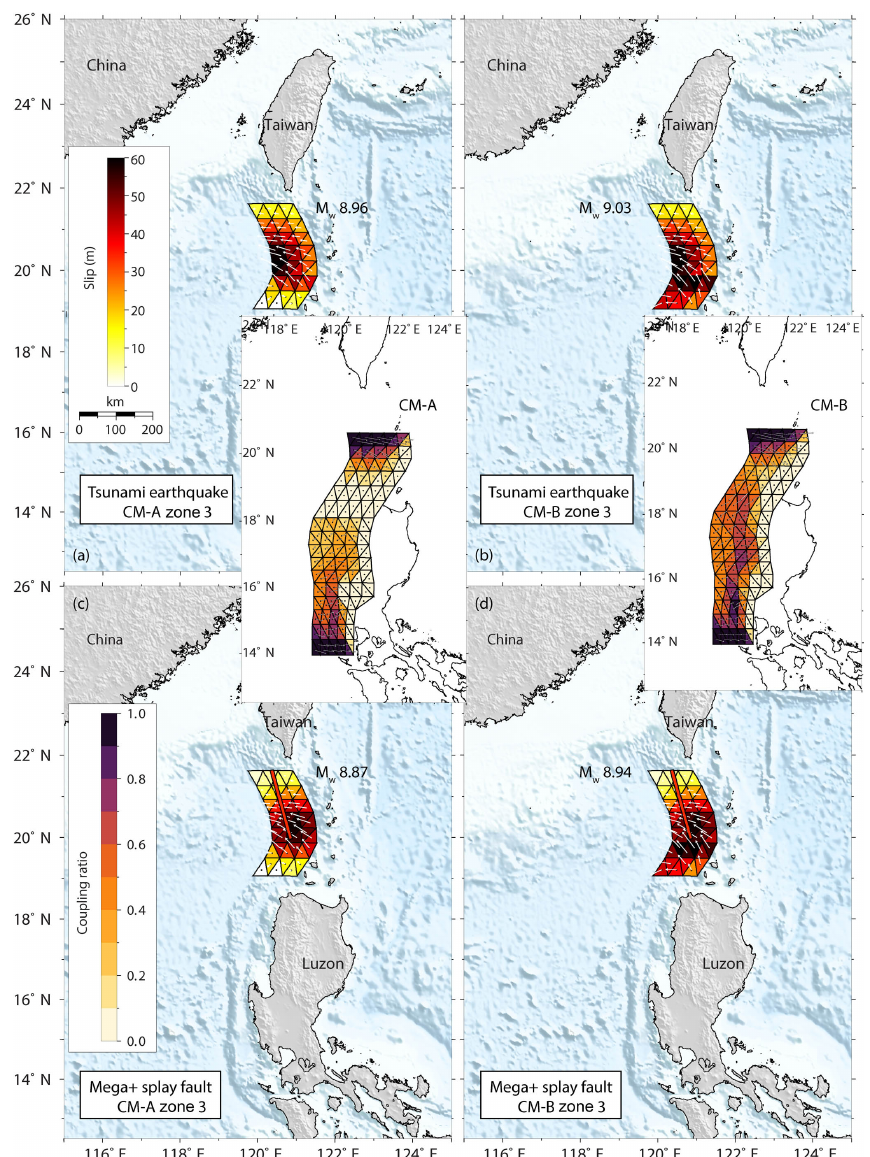
Figure 5. Proposed slip models in zone 3. Panels (a, b) show the shallow rupture type of slip models (e.g., Tohoku-Oki) based on coupling models A and B (Hsu et al., 2016), respectively. Panels (c, d) represent megathrust (Fig. 3c and f) rupture and the out-of-sequence megasplay type of slip models, respectively. We assume 50% coupling for the megathrust and the megasplay faults. CM refers to the coupling model shown in the inset map. White arrows show the possible slip directions during earthquakes. Vectors in the coupling maps show the slip deficit direction that is accumulated for future release in